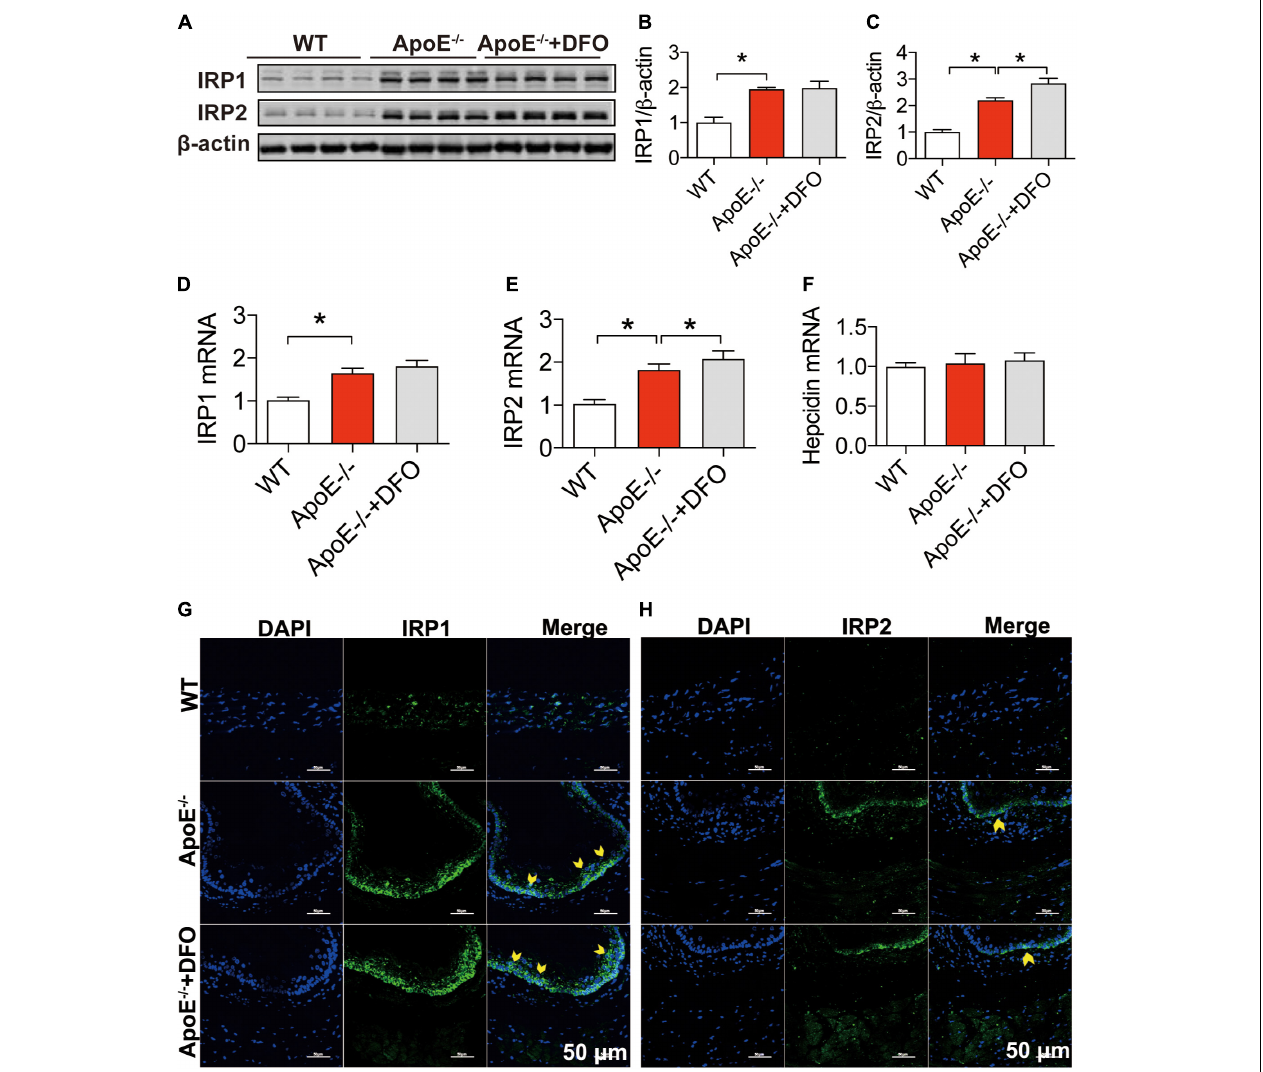
FIGURE 3 | ApoE deficiency up-regulated IRP1 and IRP2 expression but not hepcidin in the aortic tissues. The expression of IRP1 and IRP2 proteins [IRP1, (A,B) ; IRP2, (A,C) ], mRNAs [IRP1, (D) ; IRP2, (E) ] and hepcidin mRNA (F) in the aortic tissues were, respectively, determined by Western blot and RT-PCR analysis as described in section “Materials and Methods” in WT ( n = 8; WB: n = 3), ApoE – / – ( n = 8; WB: n = 3) and ApoE – / – + DFO ( n = 8; WB: n = 3) mice, all aged 28 week-old. Immunofluorescence analysis of IRPs protein expression in the aortic tissue (G,H) was also conducted in the three groups of mice. The mice in ApoE – / – + DFO group received daily i.p. injections of 100 mg/kg body weight (b.w.) of DFO in HBSS for 14 days. Scale bar in panel (H) = 50 µ m. Data are presented as the mean ± SEM. * p <